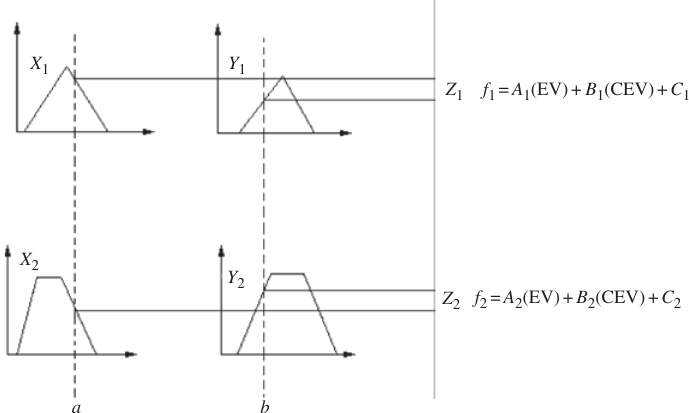
Figure 3: First Order Takagi–Sugeno Interference